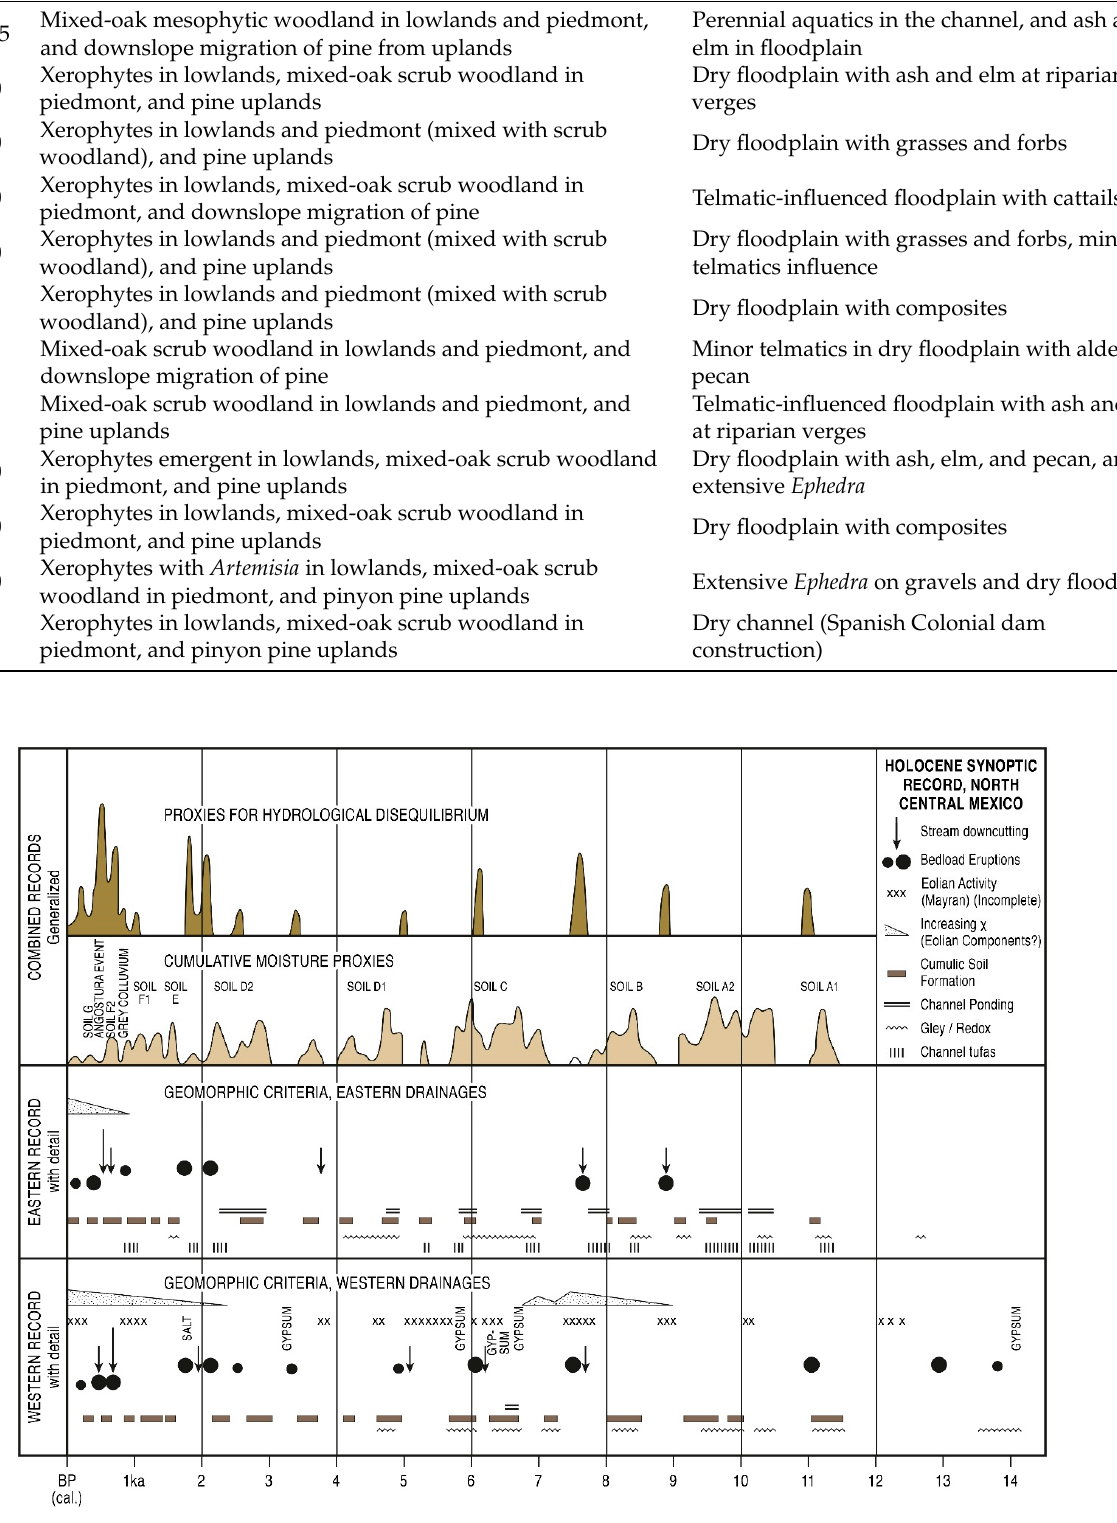
Table 4. Zonal and azonal vegetation changes in the Holocene at Upper Arroyo. Y. BP